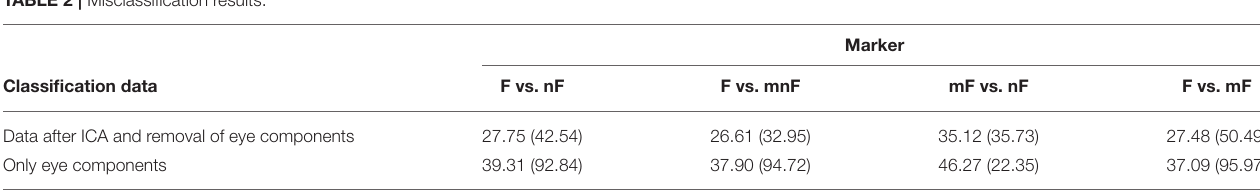
TABLE 2 | Misclassification